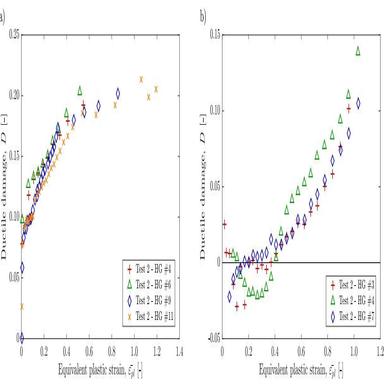
Ductile damage - equivalent plastic strain experimental results: (a) stainless steel 304L; (b) copper C110.